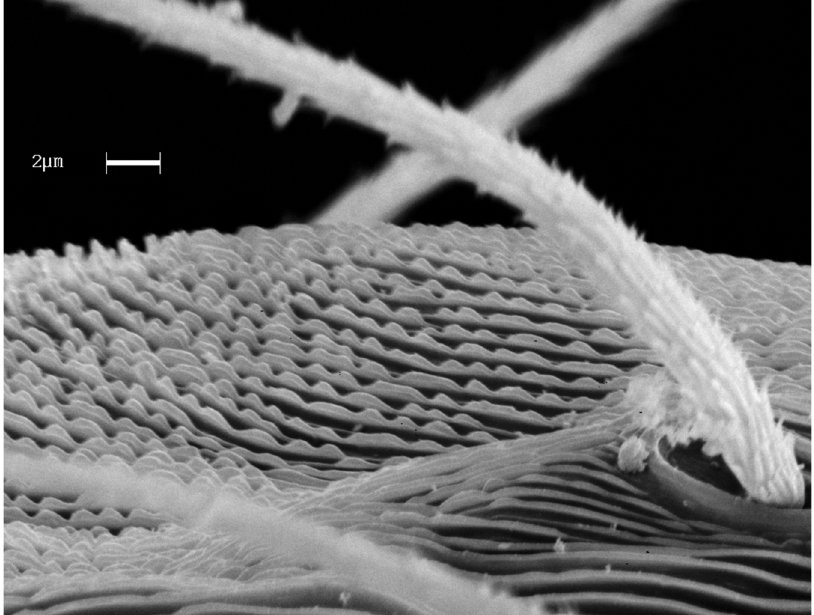
Fig. 14. Details of cuticle structure of Tetranychus urticae